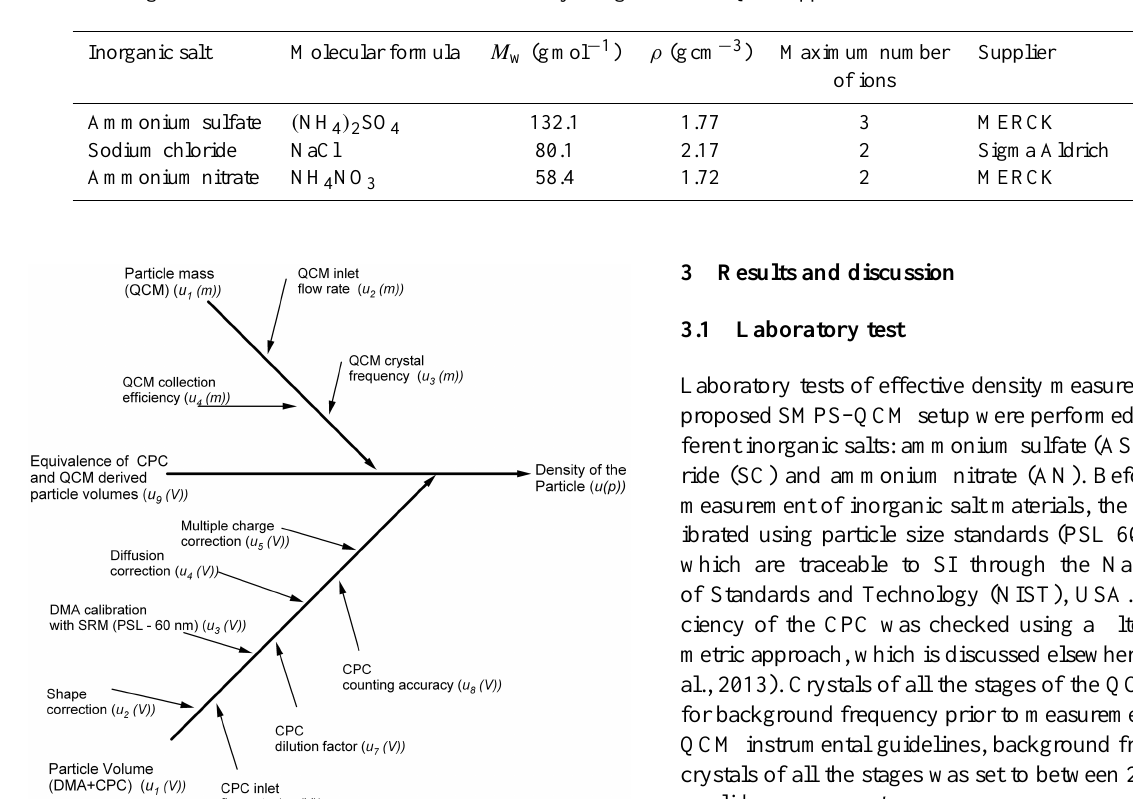
Table 1. Inorganic salts used for the measurement of density using the SMPS–QCM approach.